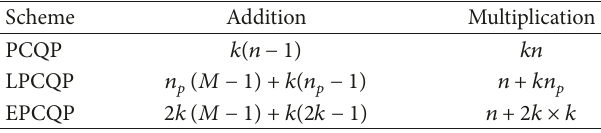
Table 1: Comparison of computation cost on the server.